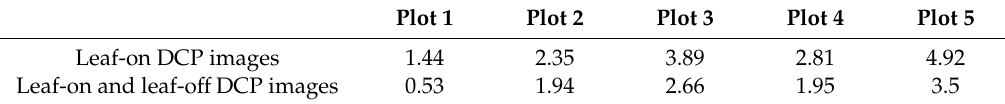
Table 8. LAI derived from DCP using two calculation schemes. One scheme calculates the LAI from the leaf-on DCP images (Equation (15)), and the other scheme calculates the LAI based on the PAI and WAI derived from the leaf-on and leaf-o ff DCP images, respectively (Equation (16)). Plot 1 Plot 2 Plot 3 Plot 4 Plot 5 Leaf-on DCP images